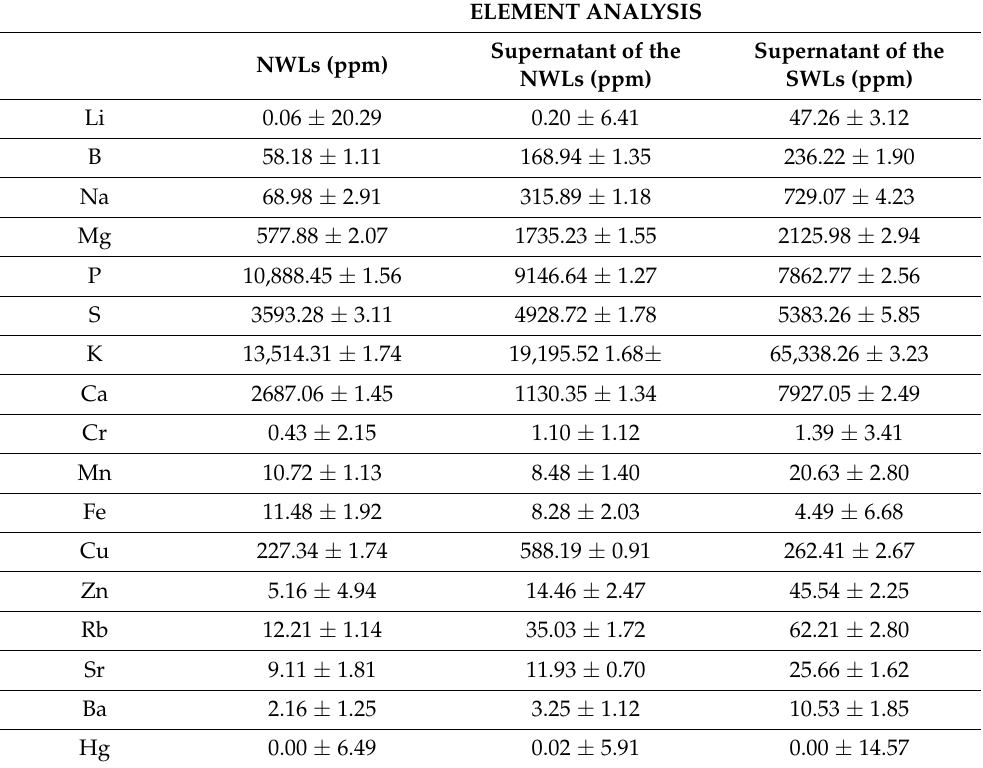
Table 7. Different concentration of element in the samples of wine lees before and after treatments of sonication and centrifugation. ELEMENT ANALYSIS NWLs